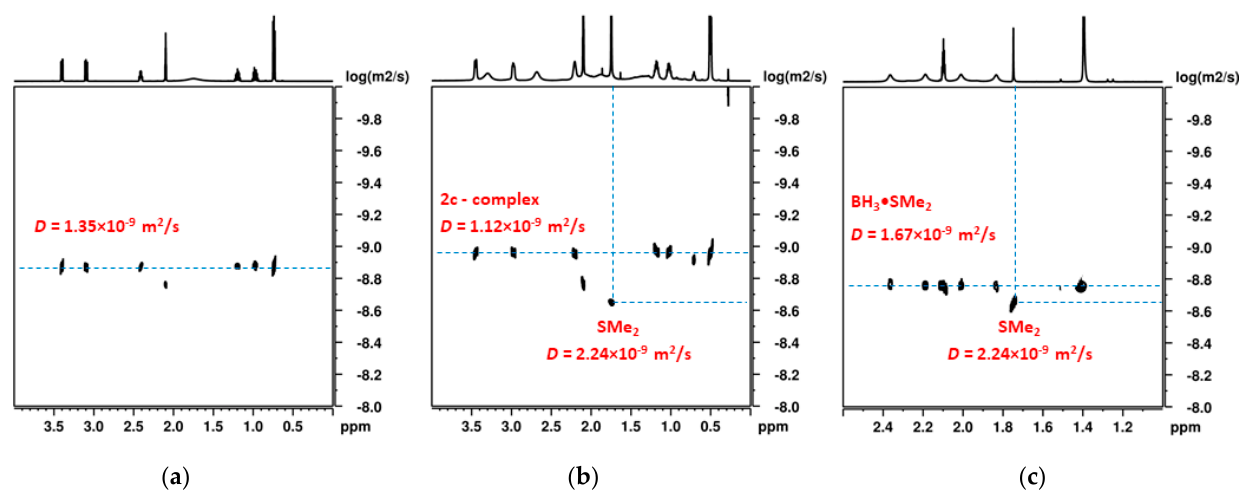
Figure 2. 1 Н DOSY spectra of: ( а ) pure ligand 2c in toluene − d 8 , ( b ) 2c in the presence of BH 3 ·SMe 2 and ( c ) BH 3 •SMe 2 in Figure 2. 1 H DOSY spectra of: ( a ) pure ligand 2c in toluene − d 8 , ( b ) 2c in the presence of BH 3 · SMe 2 and ( c ) BH 3 • SMe 2 in toluene-d 8 . toluene-d 8